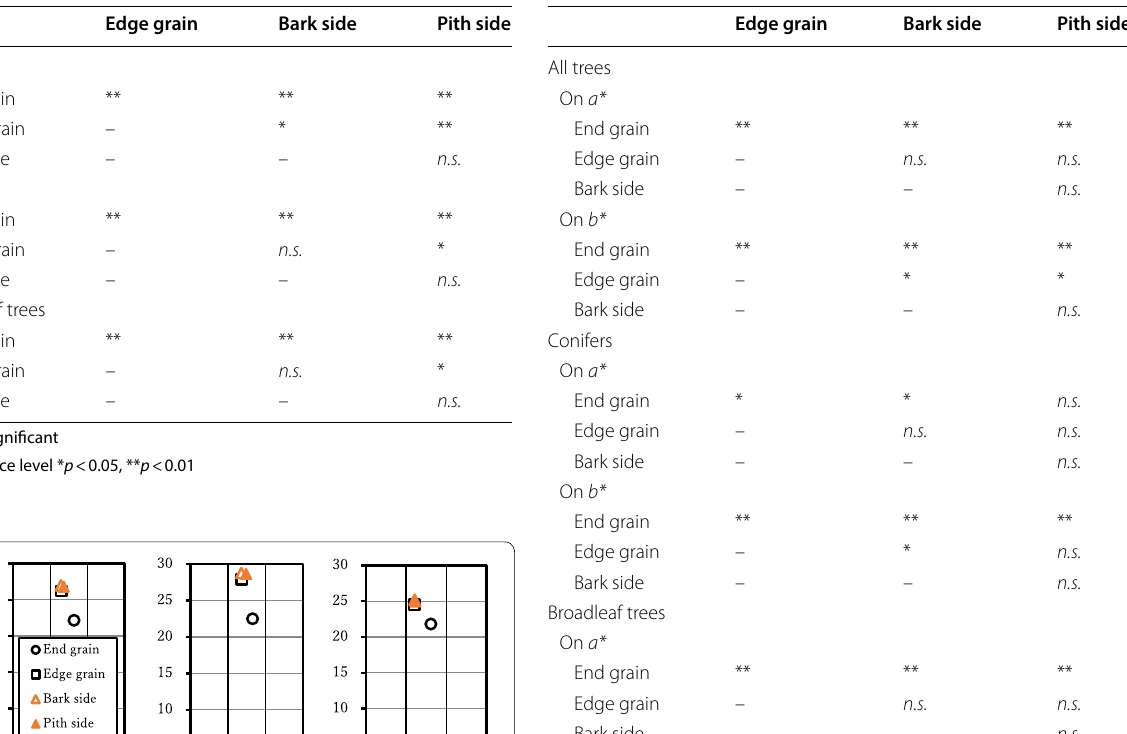
Table 4 Paired t test results of differences between each measuring plane average on L * in Fig. 4